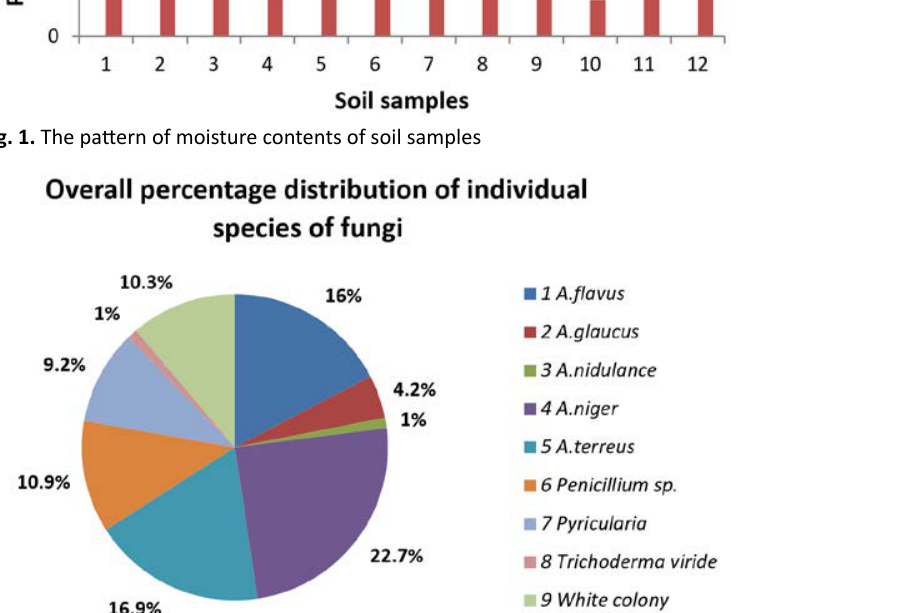
Fig. 2. Overall percentage occurrence of individual species of fungi in soil